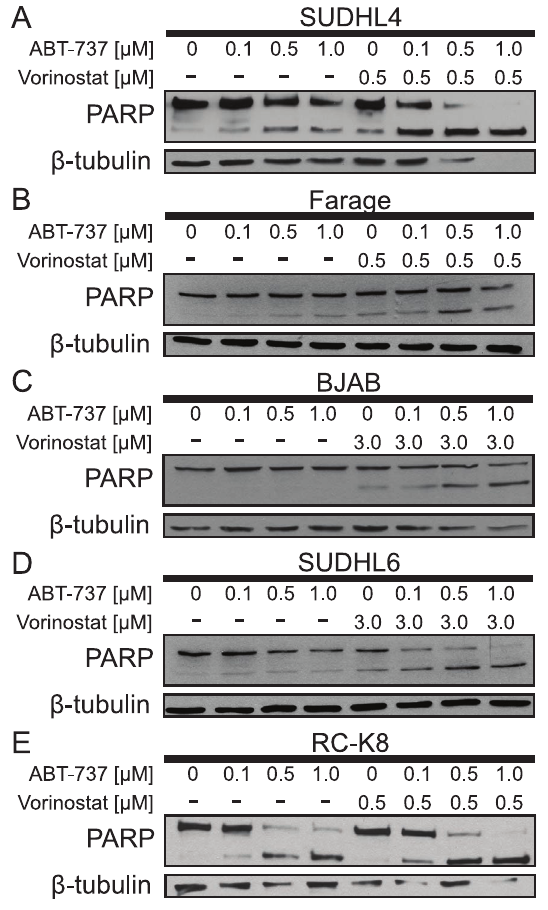
Figure 4. Vorinostat and the BH3 mimetic ABT-737 cooperate to increase apoptosis in DLBCL cell lines. ( A ) SUDHL4, ( B ) Farage, ( C ) BJAB, ( D ) SUDHL6, and ( E ) RC-K8 cells were treated with ABT-737 in a dose-dependent manner with and without a sub-optimal level (0.5 m M) or a higher concentration (3 m M) of vorinostat. Whole-cell extracts were subjected to Western blotting to assess PARP cleavage and b -tubulin levels (as a normalizing control).